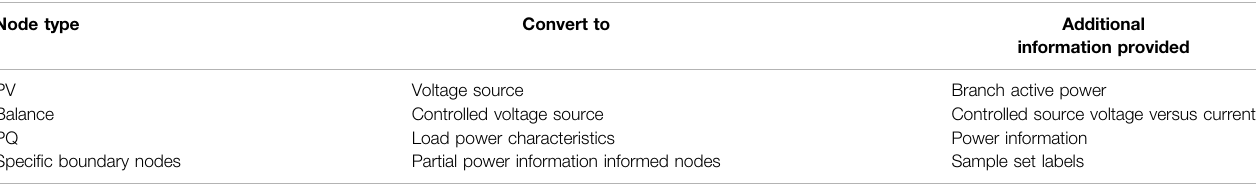
TABLE 1 | Conversion scheme of the power network for linear operation.